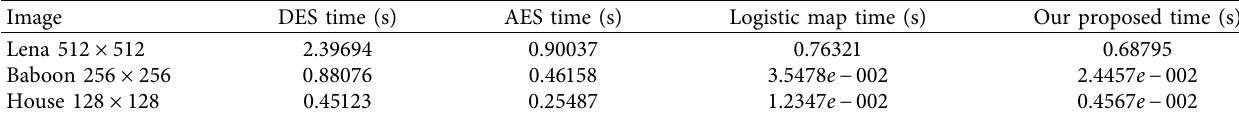
Table 9: Encrypted speed of each